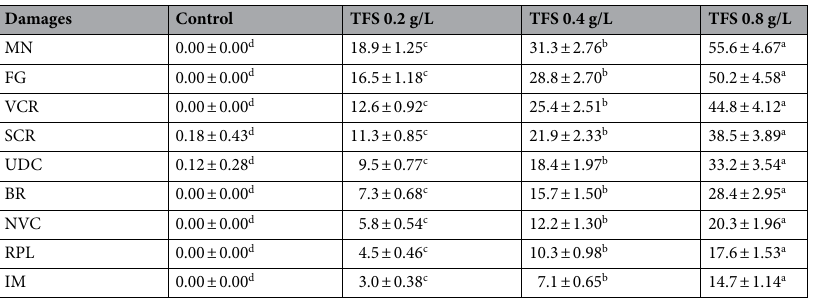
Table 2. Genotoxicity induced by Trifoxystrobin. The averages shown with different letters (a–d) in the same line are significantly different at p < 0.05. MN micronucleus, FG fragment, VCR vagrant chromosome, SCR sticky chromosome, UDC uneven distribution of chromatin, BR bridge, NVC nucleus with vacuoles, RPL reverse polarization, IM irregular mitosis.